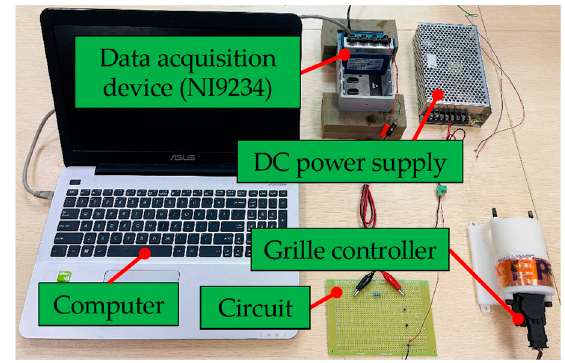
Figure 13. The experimental platform of the grille controller.